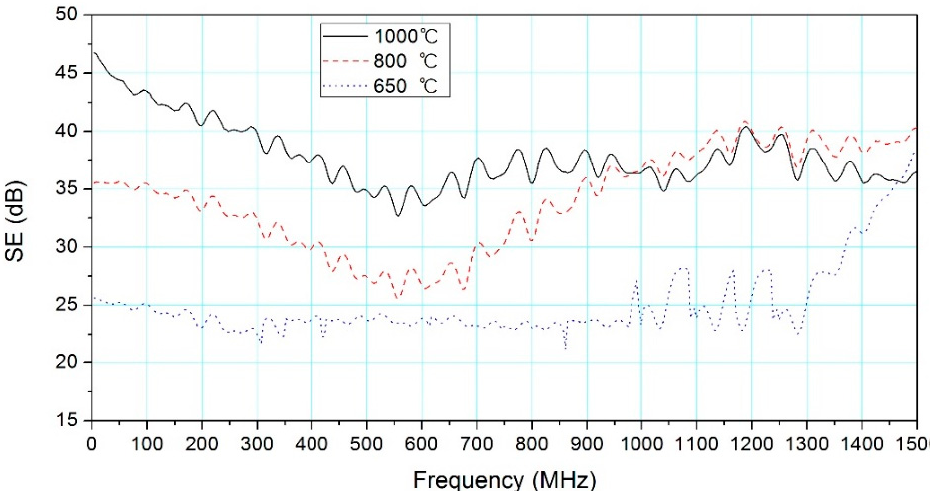
Figure 4. Effect of carbonization temperature on SE (wood:resin = 50:50, apparent density of 0.649 g/cm 3 (650 °C), 0.645 g/cm 3 (800 °C) and 0.639 g/cm 3 (1000 °C) respectively). SEs (800 °C) were mostly over 30 dB in the tested frequency range. SE decreased from 35 to 26 dB